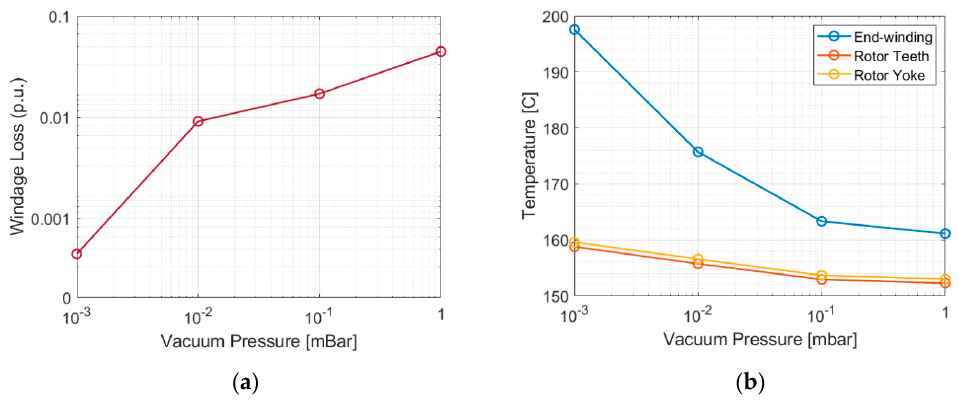
Figure 10. Trade-off 4 plots: ( a ) windage loss vs. vacuum pressure, windage loss are expressed in per-unit of the rated power; ( b ) end-winding and rotor temperatures vs. vacuum pressure.